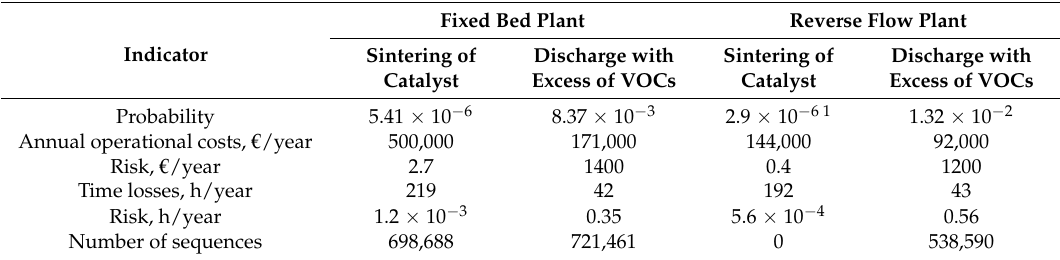
Table 4. Fixed bed plant and reverse flow plant